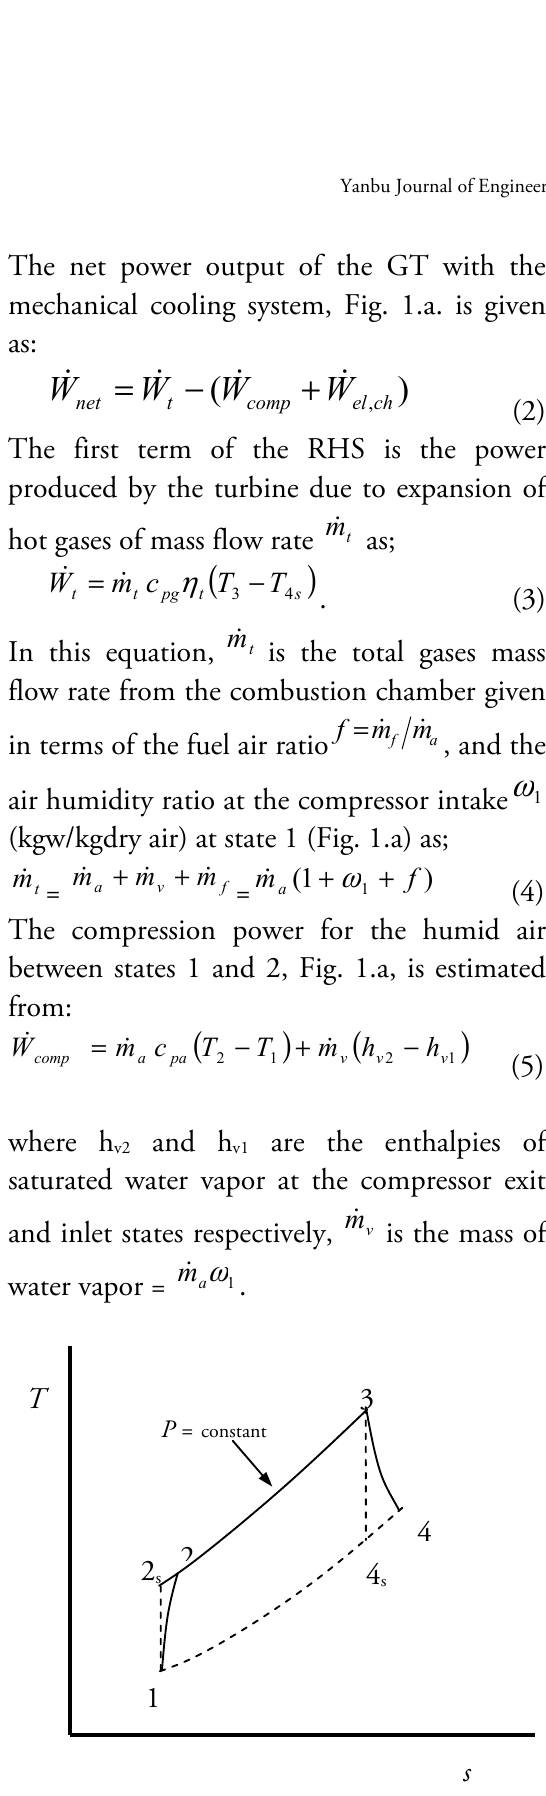
Fig. 1.b. T-s diagram of an open type gas turbine cycle